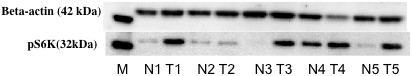
Expression of phosphorylated S6 ribosomal protein (Ser-235/236) (32 kDa) and beta actin (42 kDa) proteins in the primary tumor tissues using Western blotting. M; marker. N; non-tumor tissue. T; primary tumor tissue with metastatic lesions. Each number corresponds to a case number.